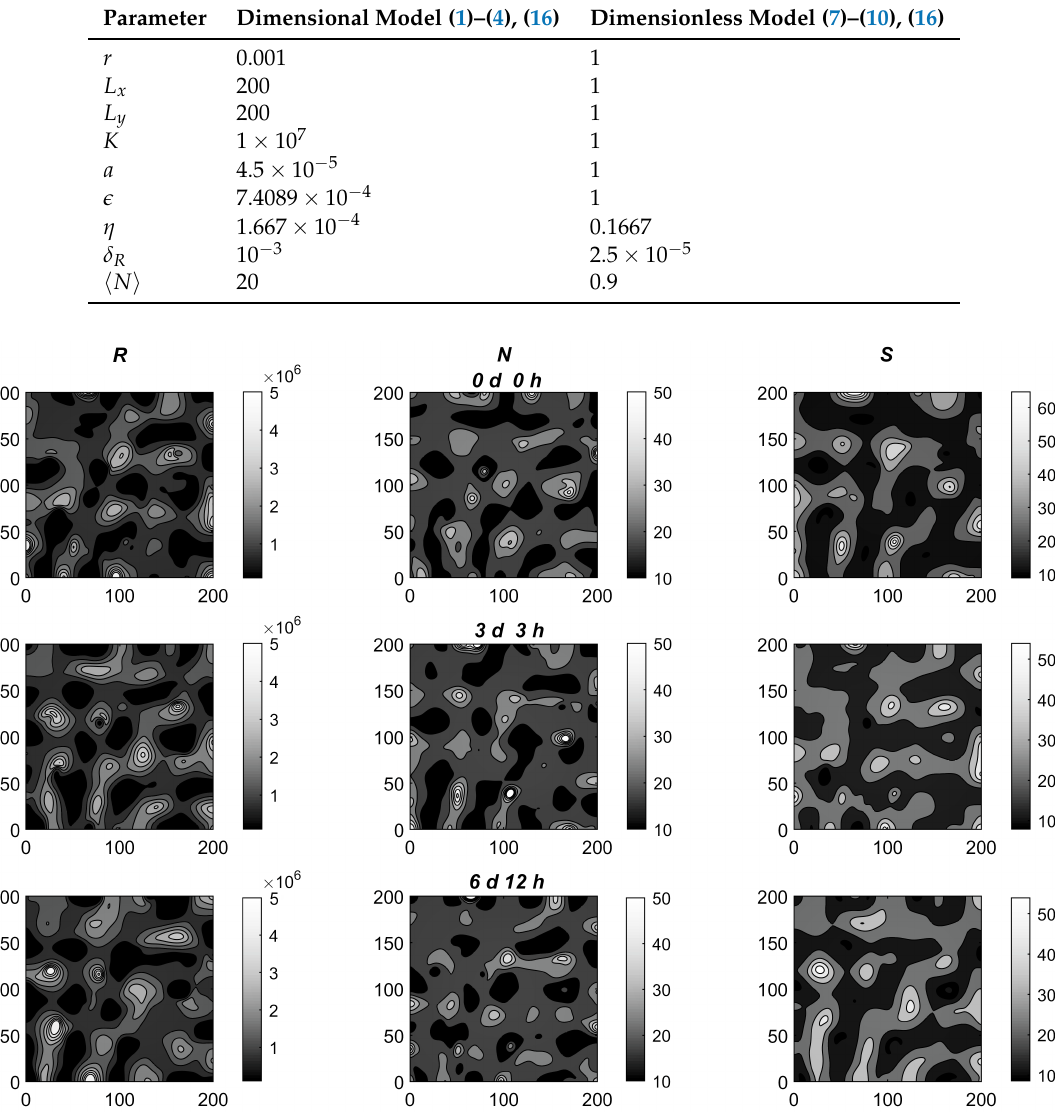
(cid:0) (cid:1) cells · cm − 2 , harpacticoid (cid:16) (cid:17) algal cells · ind − 1 · cm − 2 at the